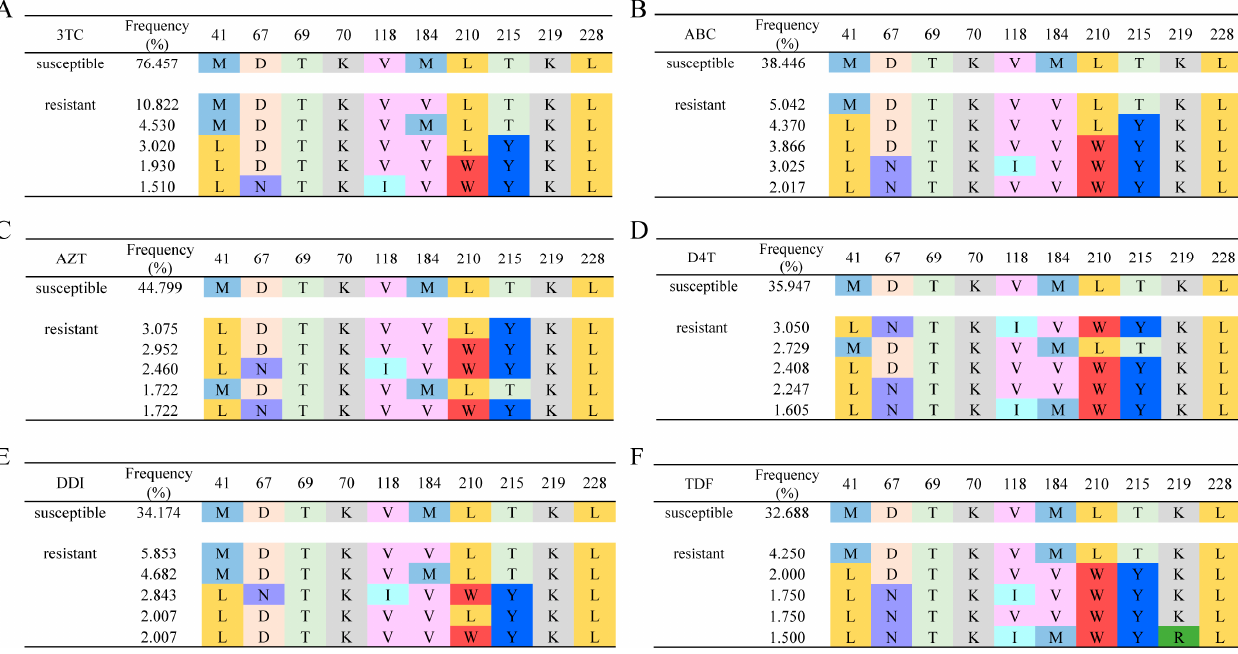
Figure 6. Peptide distribution for drug-susceptible and drug-resistant proteins. Subgraph ( A – F ) refers to peptide distribution for 3TC, ABC, AZT, D4T, DDI, and TDF related drugs. On each subgraph, the first line refers to the most frequent peptide on drug-susceptible proteins. The following line refers to the frequently occurred peptide on drug-resistant pro- teins.